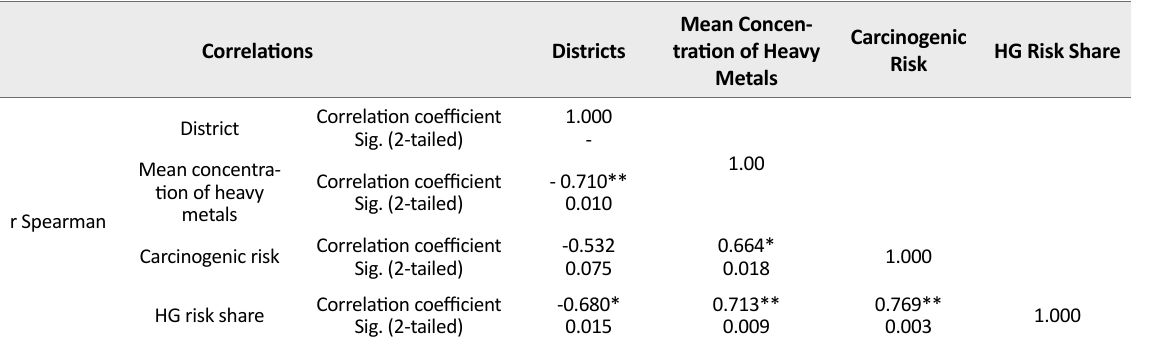
Table 4. The spearman correlation coefficients of heavy metal concentrations with carcinogenic risk and HQ in high-traffic